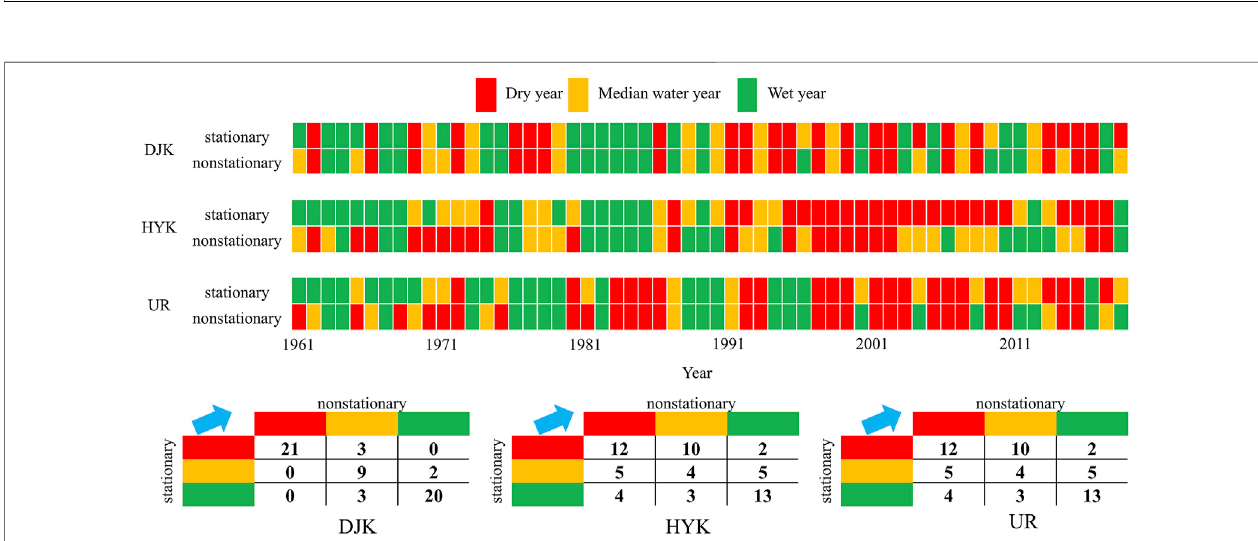
FIGURE 6 | Classi fi cation results and transfer matrices of runoff series based on the stationary model against the non-stationary model in DJK, HYK, and UR (red: dry year; yellow; median water year; and green: wet year).